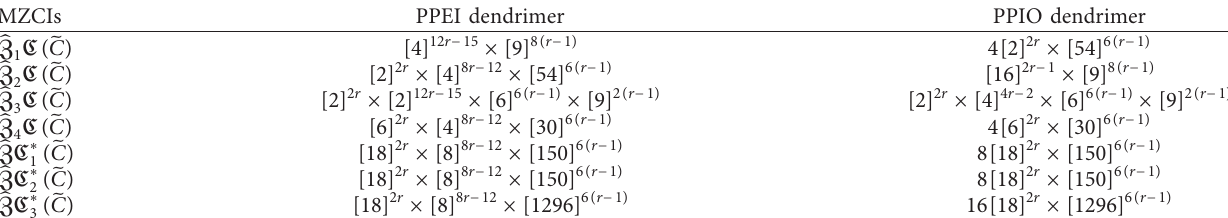
Table 3: Comparison between the value of PPEI and PPIO